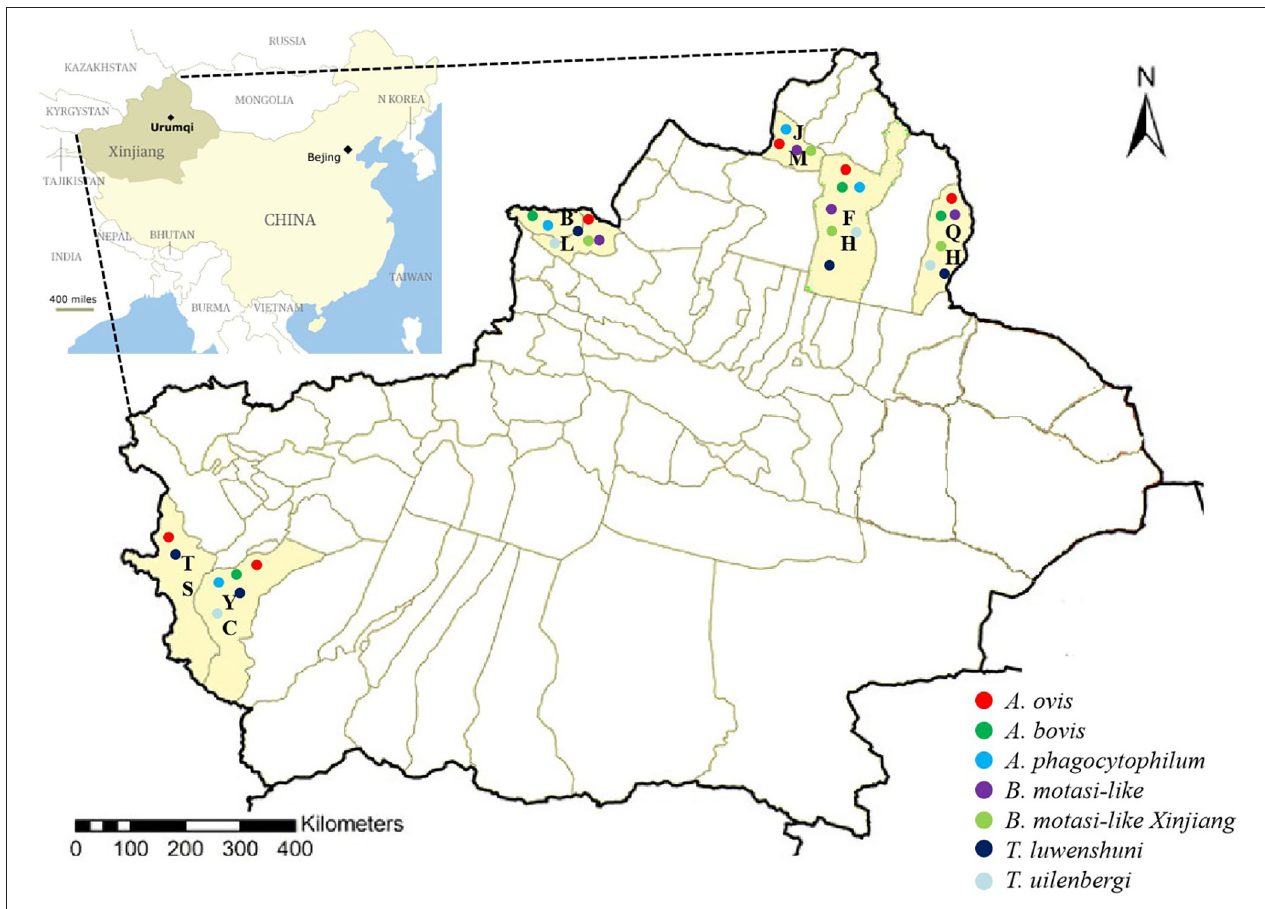
FIGURE 1 | Map of XUAR, China. Dots indicate localities which pathogens were